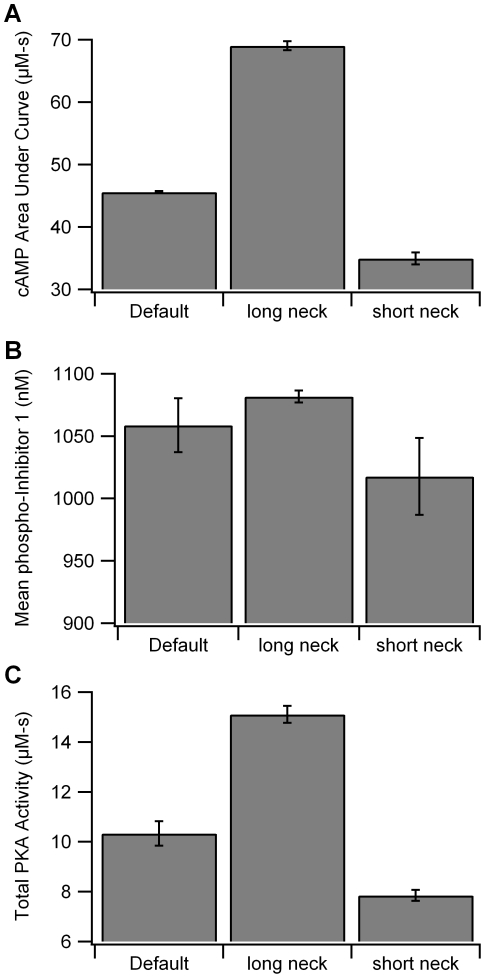
Spine neck length modulates amplitude of colocalization effect.Longer spine neck length leads to an increase in cAMP(A), which is accompanied by larger phosphorylation of inhibitor-1 (B), and greater quantity of free PKA catalytic subunit (C).